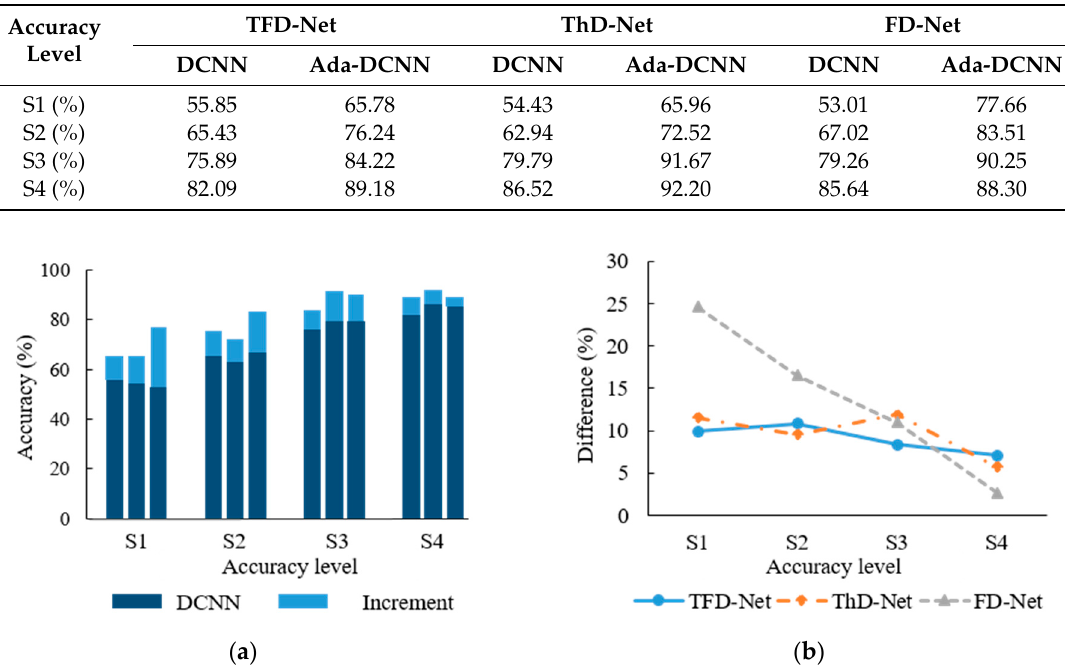
Table 6. Comparison between the performance of DCNNs and corresponding Ada-DCNNs under four accuracy levels.